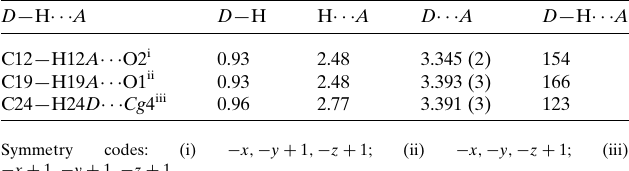
Table 1 Hydrogen-bond geometry (A˚ , (cid:4) ) for (II). Cg 4 is the centroid of the C1–C6